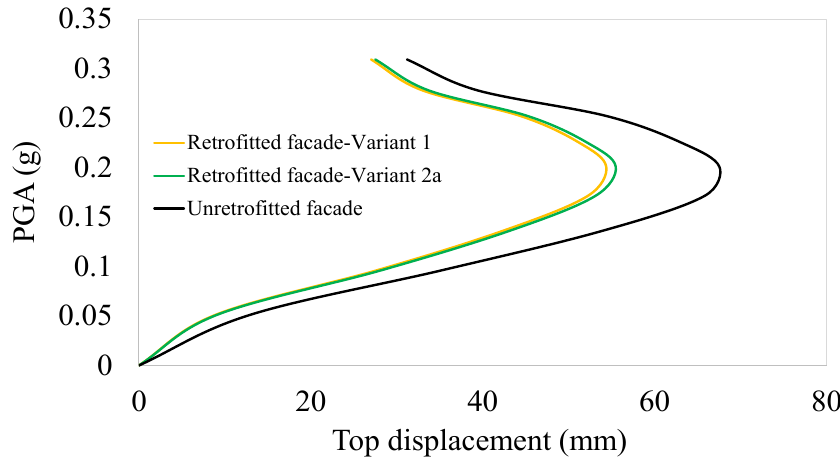
Figure 7. Mean out-of-plane IDA curve of the retrofitted facade of the building and comparison with the unretrofitted facade.